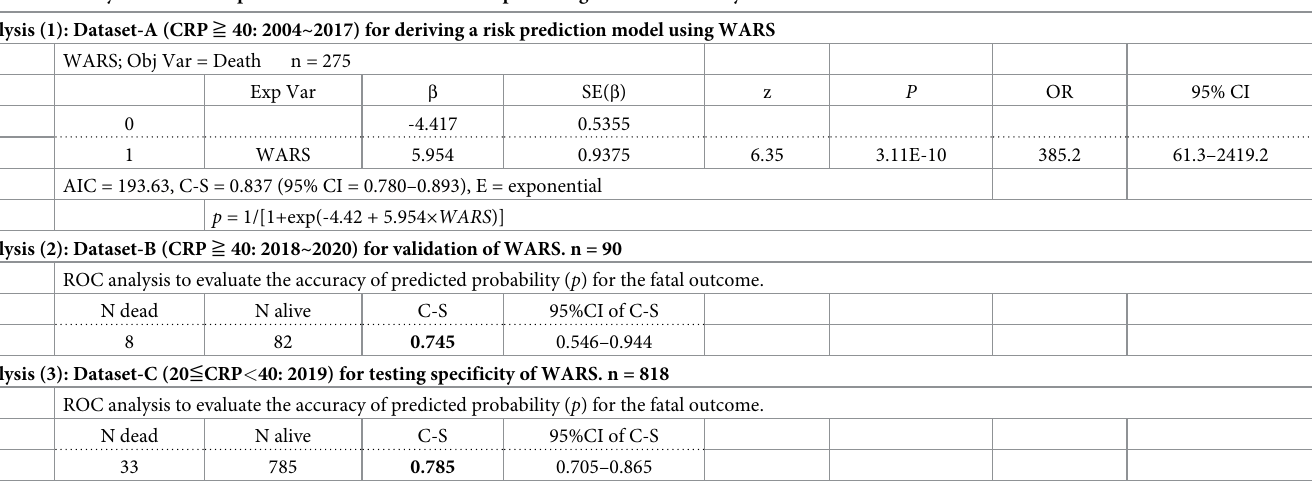
Obj Var = object variable; Exp Var = explanatory variable; β = partial regression coefficient; SE = standard error; OR = odds ratio; C-S = C-statistics; E-10 = 10 − 10 . WARS = weighted average risk